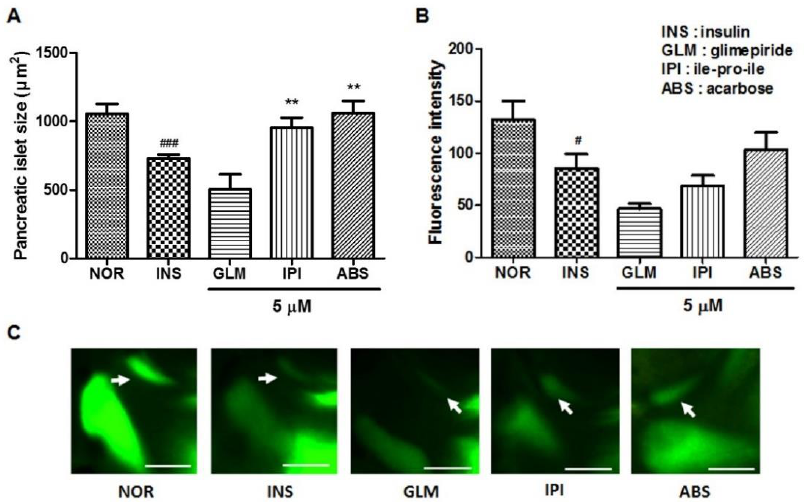
Figure 6. Effects of glimepiride (GLM), ile-pro-ile (IPI) and acarbose (ABS) on excess insulin-treated zebrafish. ( A ) Pancreatic islets ’ size. (###) p < 0.001; compared to normal group (NOR). (**) p < 0.01; compared to insulin-treated group (INS). ( B ) Fluorescence intensity in the pancreatic islets. (#) p < 0.05; compared to NOR. ( C ) Representative pancreatic islet images of the NOR, INS, GLM-, IPI- and ABS-treated zebrafish. Pancreatic islets were stained using 2-NBDG. The white arrow indicates the location of the pancreatic islet. Scale bar = 100 μm.